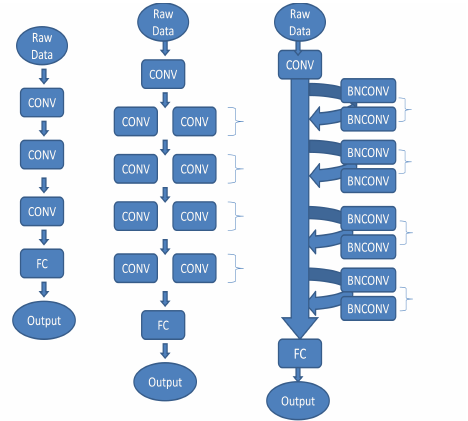
Figure 9: Overall Accuracy vs Kernel Size with varying convolu- tional layers and residual blocks